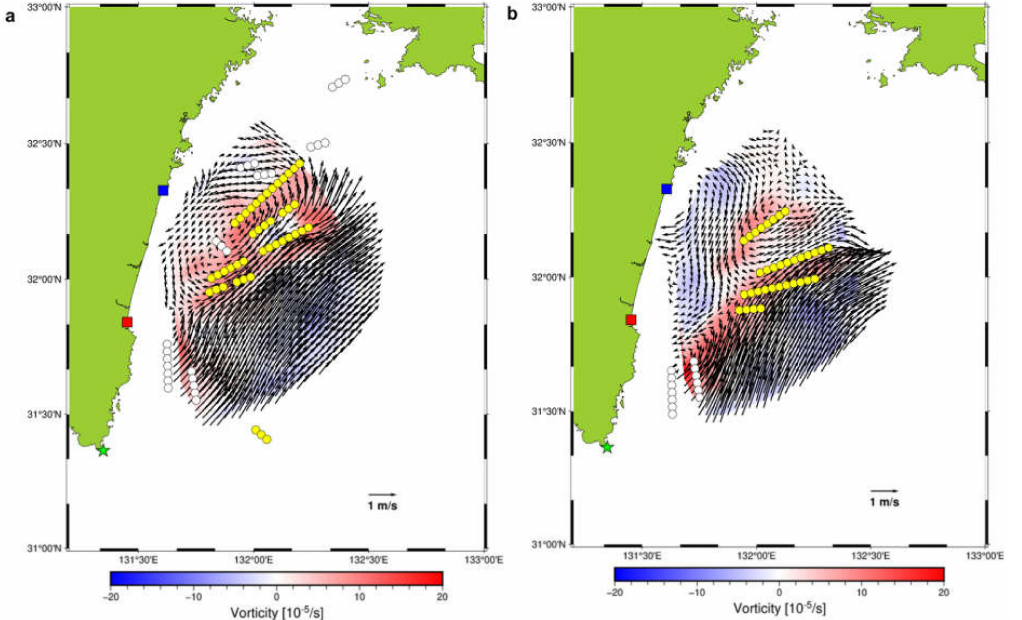
Figure 12. Comparing vorticity and double-peak spectra occurrence areas. The change in color indicates the vorticity of the area. The yellow and white circles indicate the areas in which the double-peak spectra occurred at the Miyazaki and Mimitsu Stations. ( a ) Results at 01:00 a.m. on 1 January 2019. ( b ) Results at 14:00 on 8 March 2019.